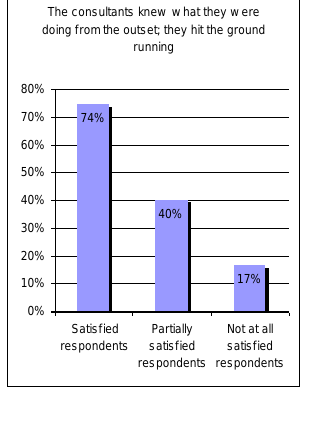
Figure 3 : … And not